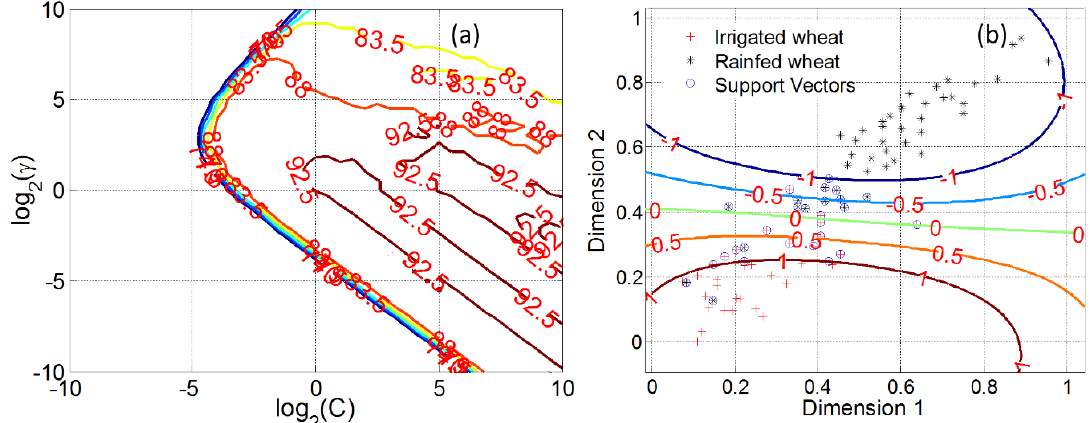
Figure 5. SVM parameter selection ( a ) and accuracy of five-fold cross-validation ( b ) for training samples. ( a ) shows the pair of global optimal parameters ( C and γ ) through the grid search; ( b ) is the visualization of classification of irrigated and rainfed wheat when the training data were mapped into a higher dimensional feature space using the RBF kernel function.